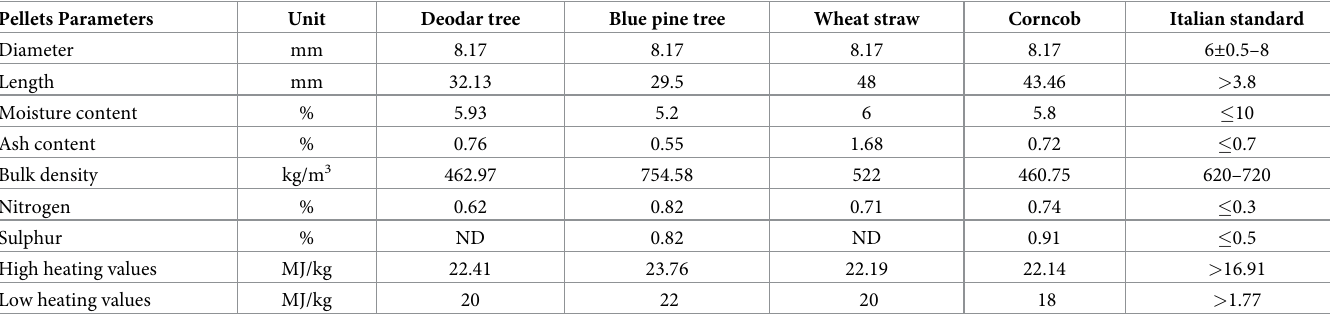
Table 2. Characterization of biomass pellets from different agro-forestry species residues. Pellets